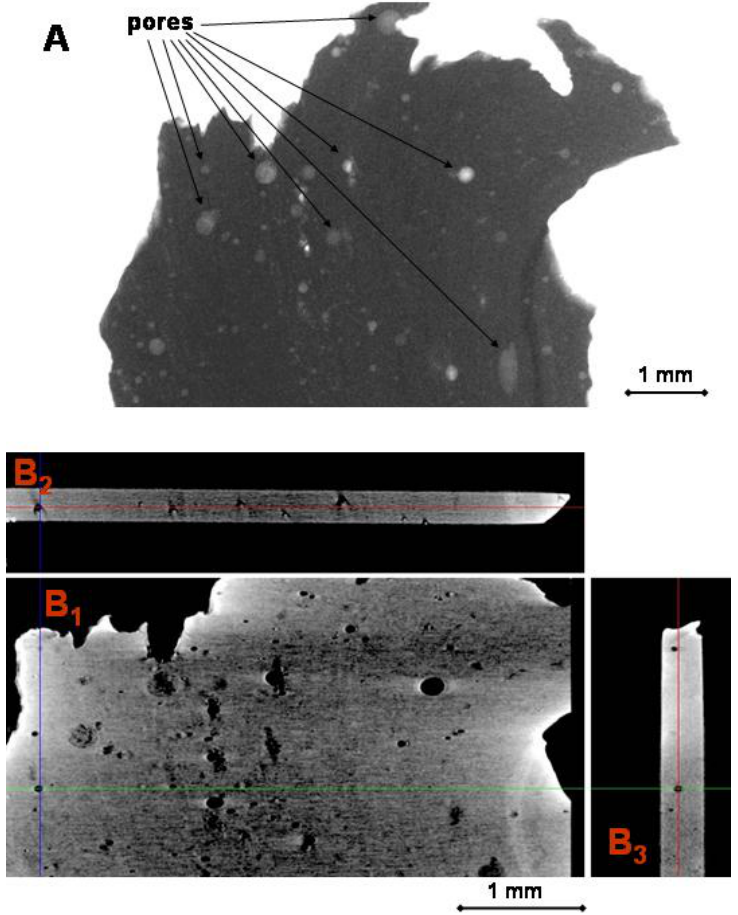
microCT sample holder. Pores, some of which are indicated by arrows, are detectable as lighter gray spots; ( B ) reconstructed slices of the VOI (volume of interest) along the ( B transaxial, ( B ) coronal and ( B ) sagittal 2 3